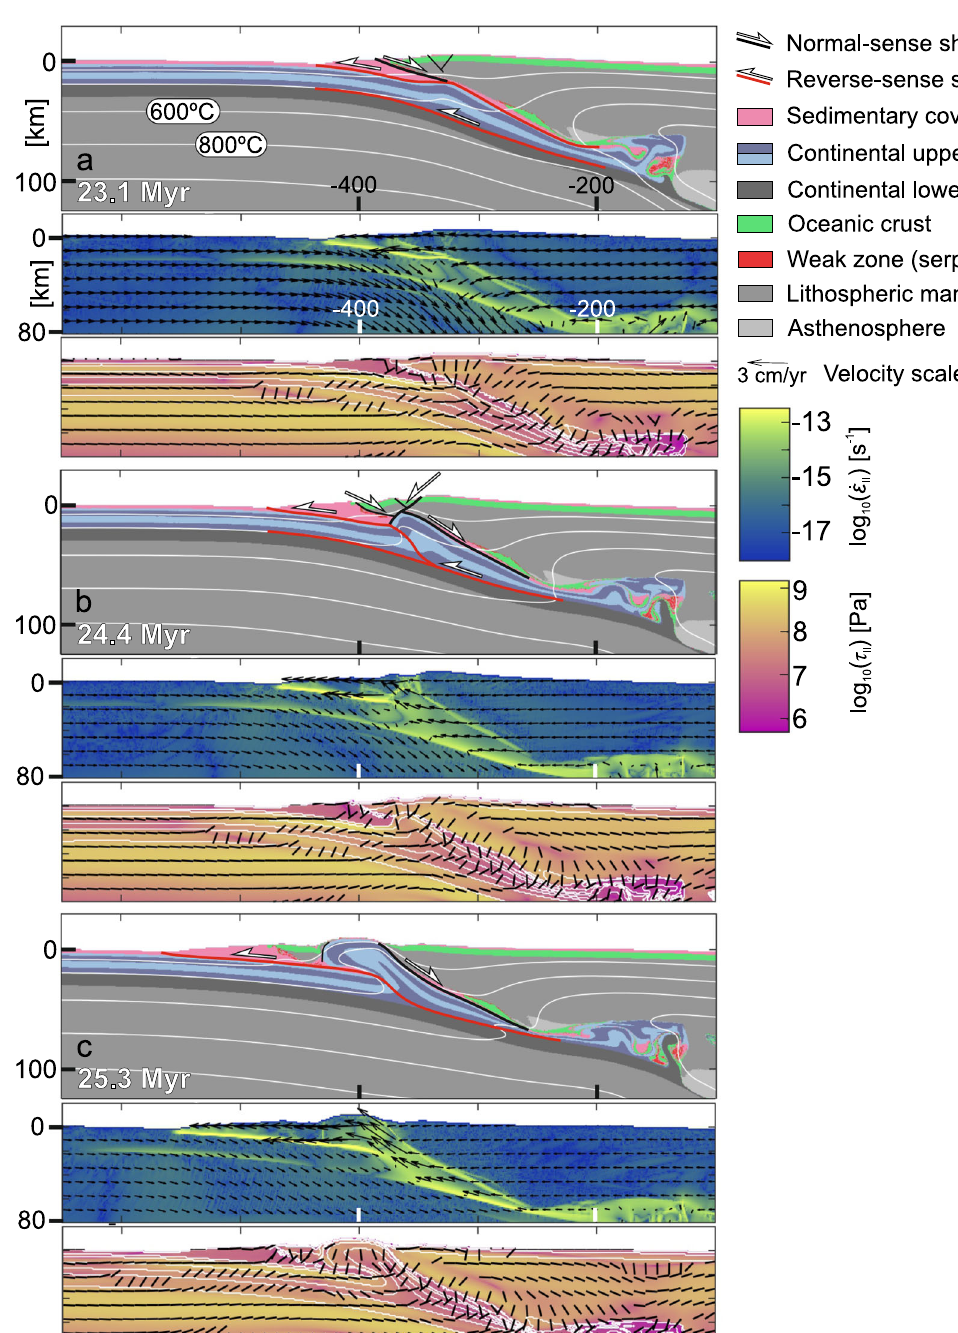
Fig. 3 Kinematic and dynamic evolution of continental upper crust extrusion and upper plate necking. Top panels show the compositional domains with the interpreted main structures (shear bands in the brittle domain are interpreted as faults), the middle panels provide information of the strain rate with velocity arrows, while the bottom panels on the second stress invariant with the orientation of the most compressive principal stress ( σ 1 ). The color fi ll of the middle and bottom panels are based on scienti fi c colormaps 58 . The orientations of σ 1 on bottom panels are shown by black lines, horizontal for compression, and vertical for extension. The boundaries of different compositional domains presented on the top panels are highlighted with white contour lines on the lower right panels. a Decoupling of the upper crust and initiation of upper plate extension. b Further localization of main thrust and extensional accommodation structures that break the upper plate. c Emplacement of far-travelled ophiolite sheet by further crustal